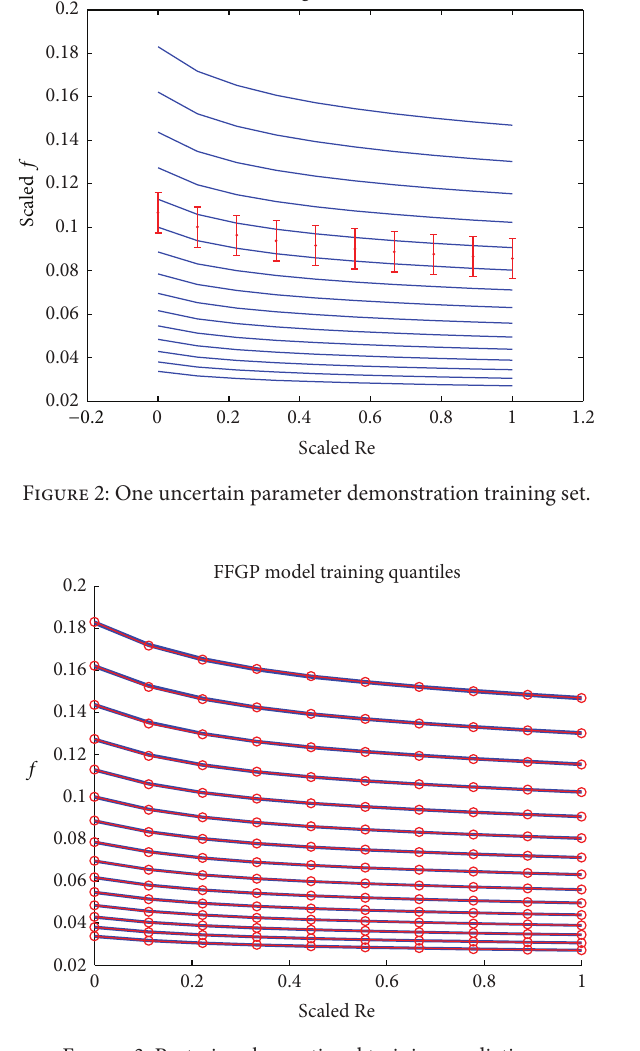
Figure 3: Posterior observational training predictions.